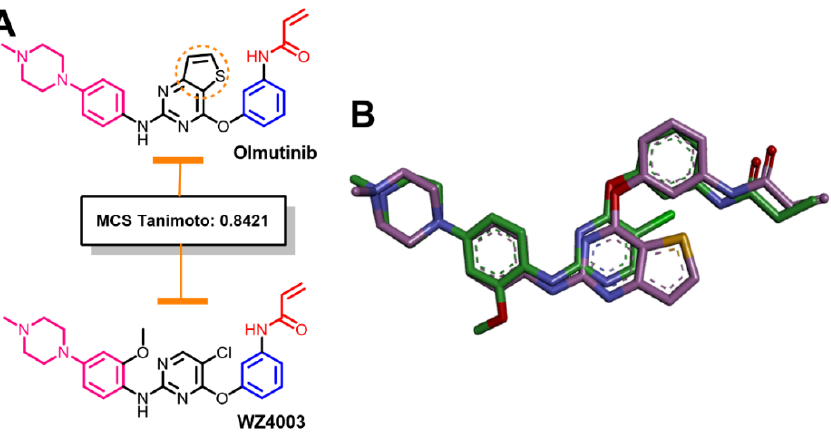
Figure 4. Structural similarity of olmutinib and WZ4003: ( A ) 2D representations showing the equivalent fragments indicated by the same color; ( B ) overlay view of the two molecules (3D rep-